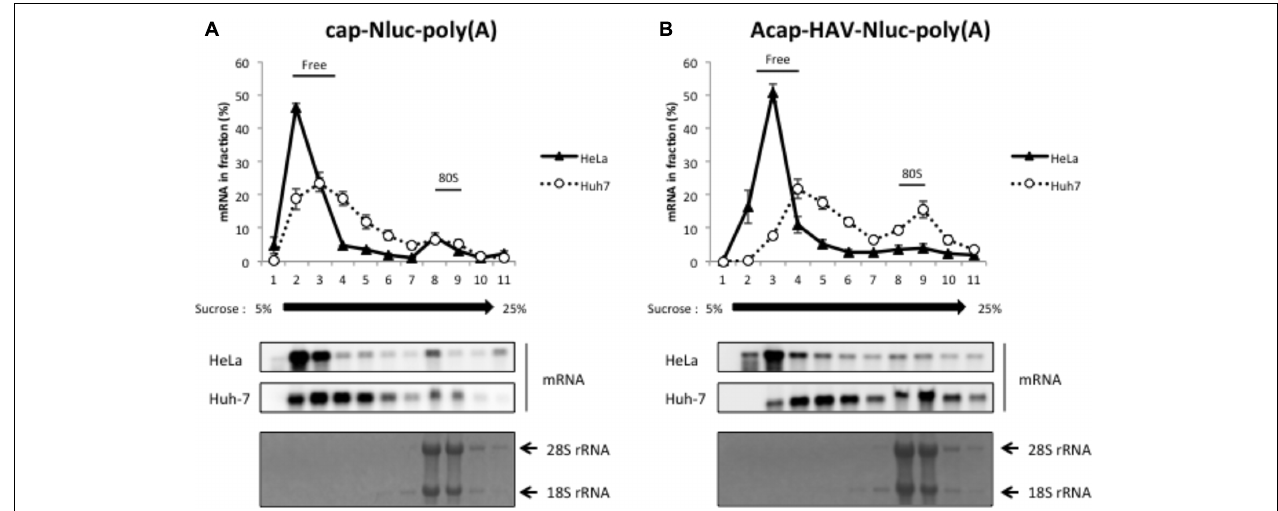
FIGURE 3 | HAV IRES-mediated translation is stimulated in Huh-7 cell extracts at the level of 80S initiation complex formation. Sucrose density gradient assay of initiation complexes formed after 10 min incubation in HeLa (black triangle) or Huh-7 (open circle) cell extracts with the cap-Nluc-poly(A) reporter mRNA (A) or Acap-HAV-IRES-Nluc-poly(A) reporter mRNA (B) . (top panel) The amount of reporter mRNA in each fraction is indicated as a percent of total mRNA signal. The mean values ± SD from three independent experiments are shown. (middle two panels) The reporter mRNAs of each fraction were detected by Northern blotting using Nluc probe. (bottom panel) rRNAs were detected by methylene blue